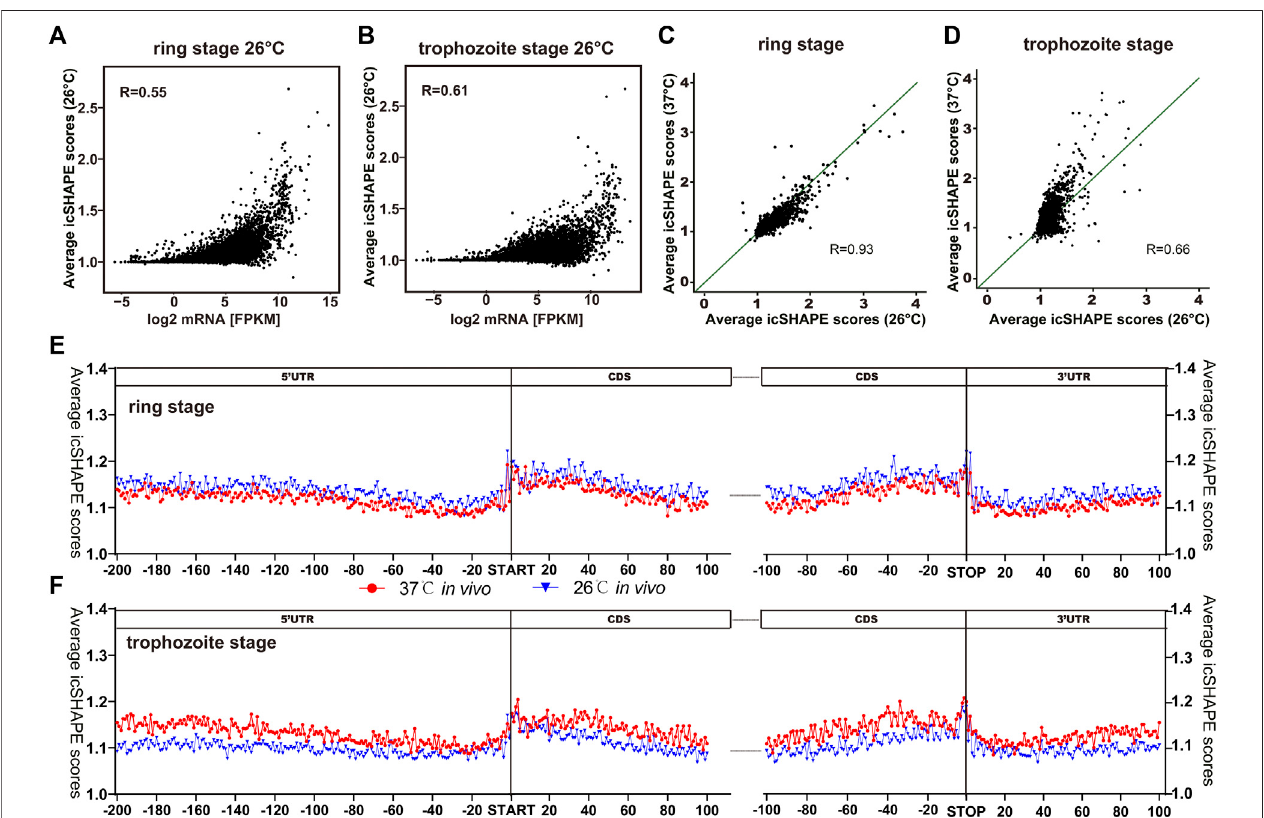
FIGURE7| FunctionalanalysisofthemeanicSHAPEscoresacrosstheentiretranscripts. (A,B) DependenceoftheaverageicSHAPEscores invivo onthemRNA expression level of the entire transcripts from the trophozoite and ring stages at 26 ° C. (C) The average icSHPE scores from the ring stage are nearly the same between 37 ° C and 26 ° C, with no signi fi cance. (D) The average icSHPE scores from the trophozoite stage are signi fi cantly greater at 37 ° C than 26 ° C. Pearson correlation coef fi cient ( R ) is showed in each panel. (E, F) The average icSHAPE score collected from the CDS regions and the UTR regions of different transcriptome in vivo amongtheringstageandtrophozoitestageafterlow-temperaturestimuli,respectively.Therearesomeregionsthathavesigni fi cantlydifferenticSHAPEscoresbetween the 37 ° C control group and the 26 ° C treatment group, such as around − 55 nt at 5 ′ -UTR region, 25 nt at CDS region, and 10 nt at 3 ′ -UTR region.